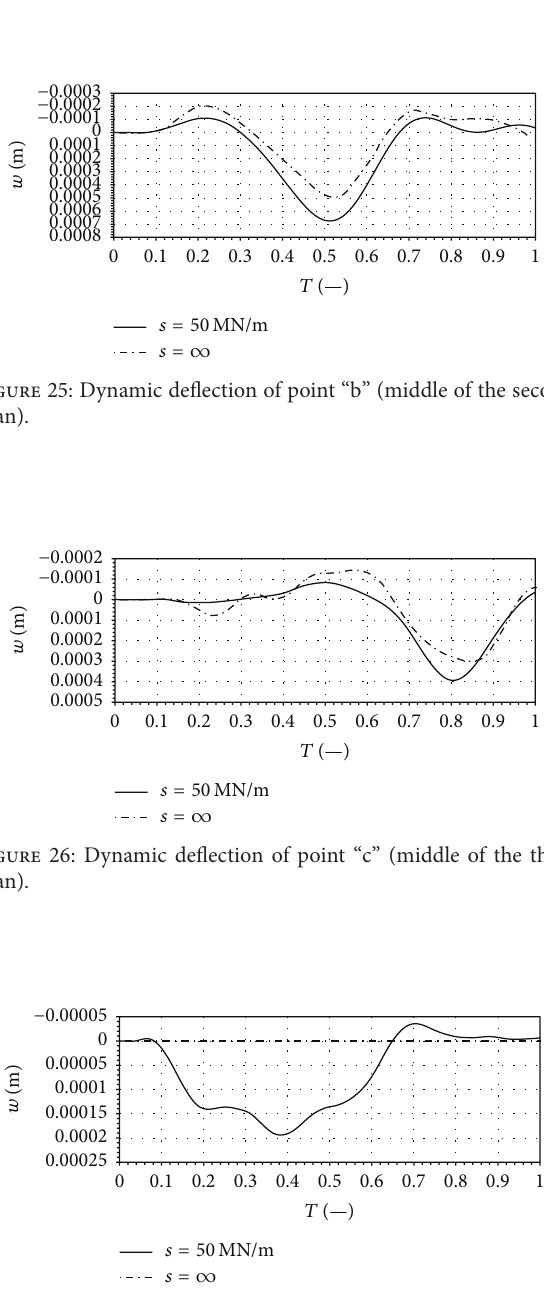
Figure 27: Dynamic deflection of support “1”.